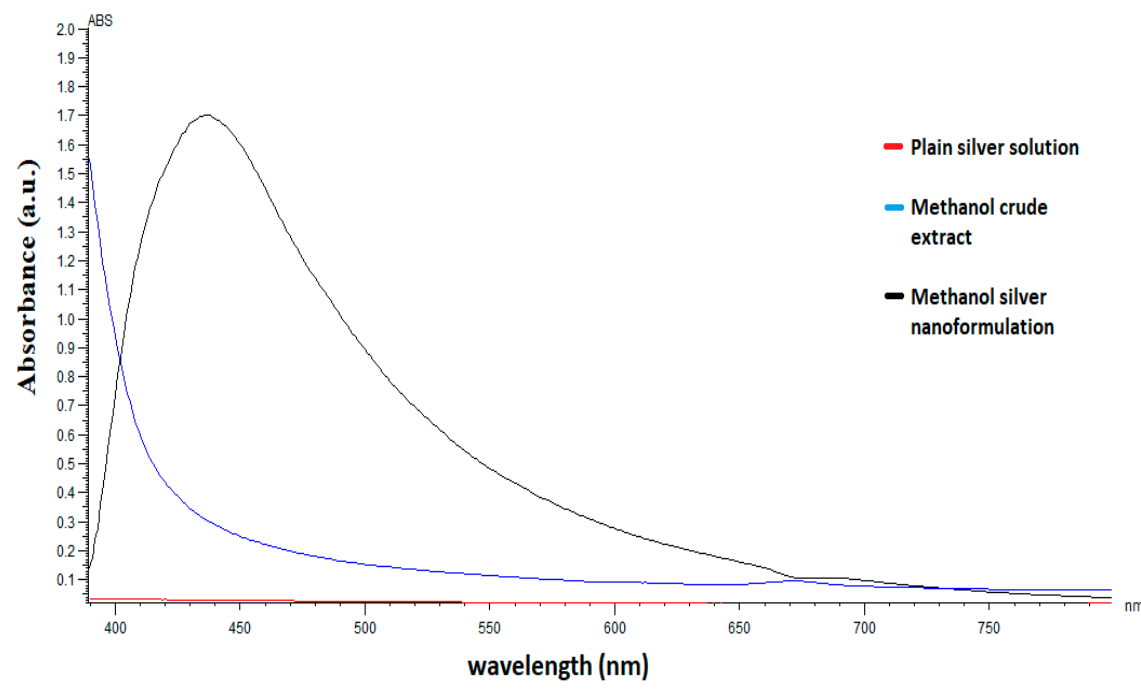
Figure 2. UV–visible spectra of methanol 70% extract of C. papaya leaf-silver nanoparticles and ab- sorbance peak noted at 450 nm.